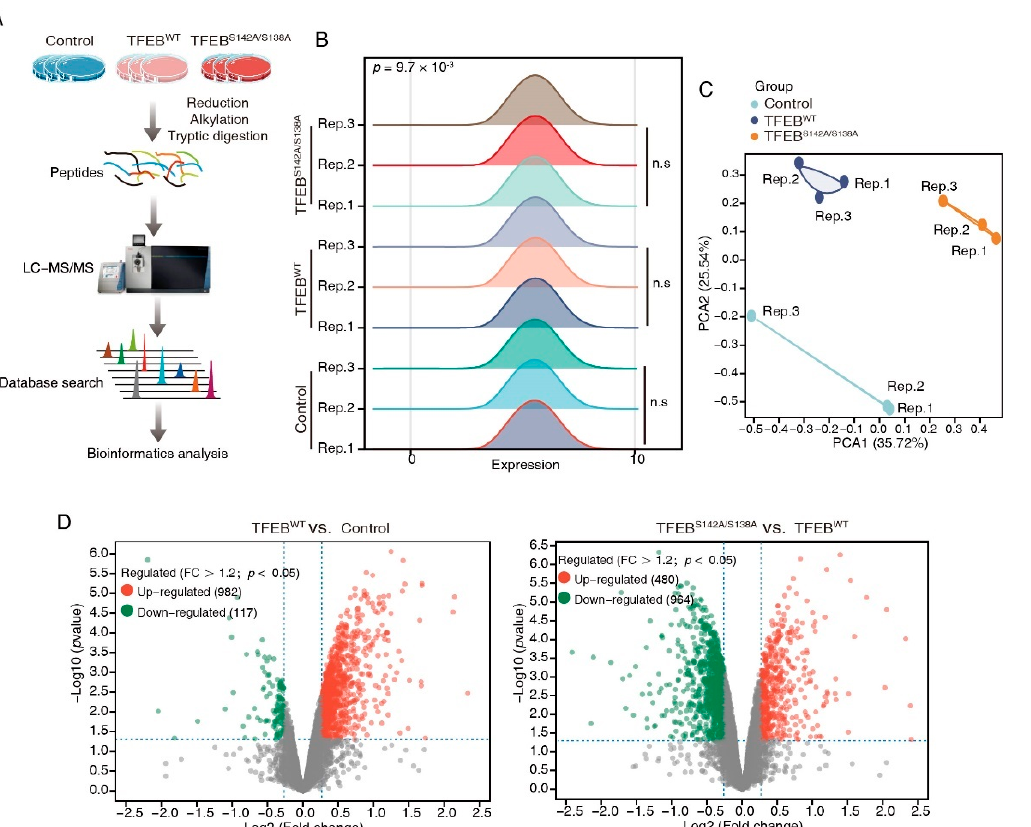
Figure 2. DIA-based quantitative proteomics characterizes TFEB targets. ( A ) The workflow of three independent DIA-MS experiments for identification of the TEFB-regulated proteins. ( B ) Ridge plots showing protein expression distribution in each group. ( C ) PCA analysis demonstrating that sam- ples in the control, TFEB WT , and TFEB S142A/S138A were separated into three discrete groups. ( D )